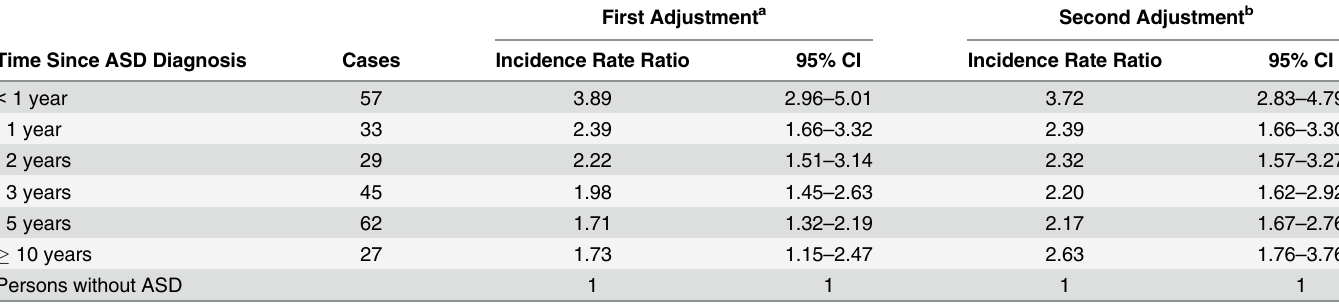
Table 3. Incidence Rate Ratio of Obsessive-Compulsive Disorder in Persons with a Diagnosis of Autism Spectrum Disorders (ASD; 1994 –